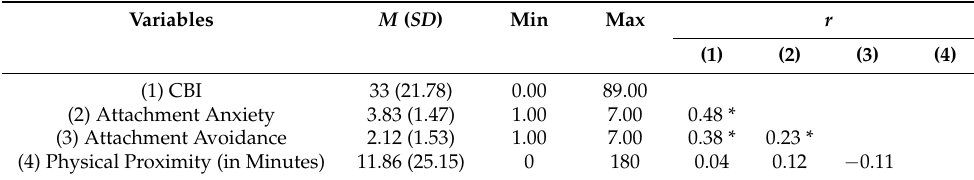
Table 2. Means, SDs and intercorrelations between caregiver burden, attachment anxiety, attachment avoidance and physical proximity to the care